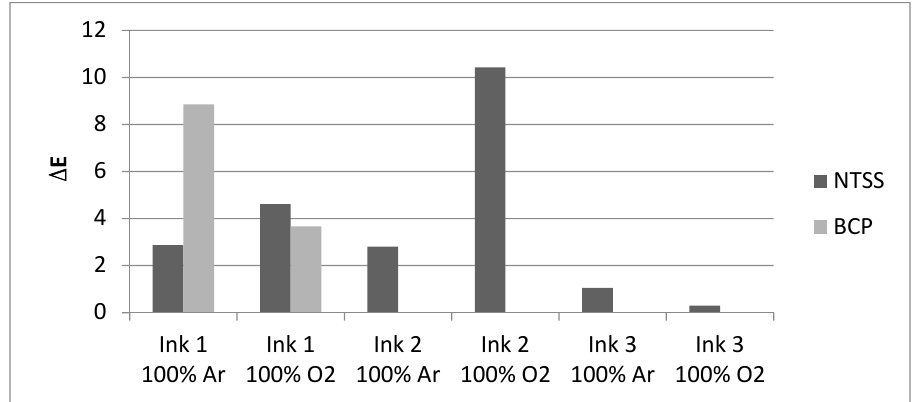
Figure 4. Color difference values between prints made on a substrate not activated before printing and activated by plasma activation using oxygen and argon.